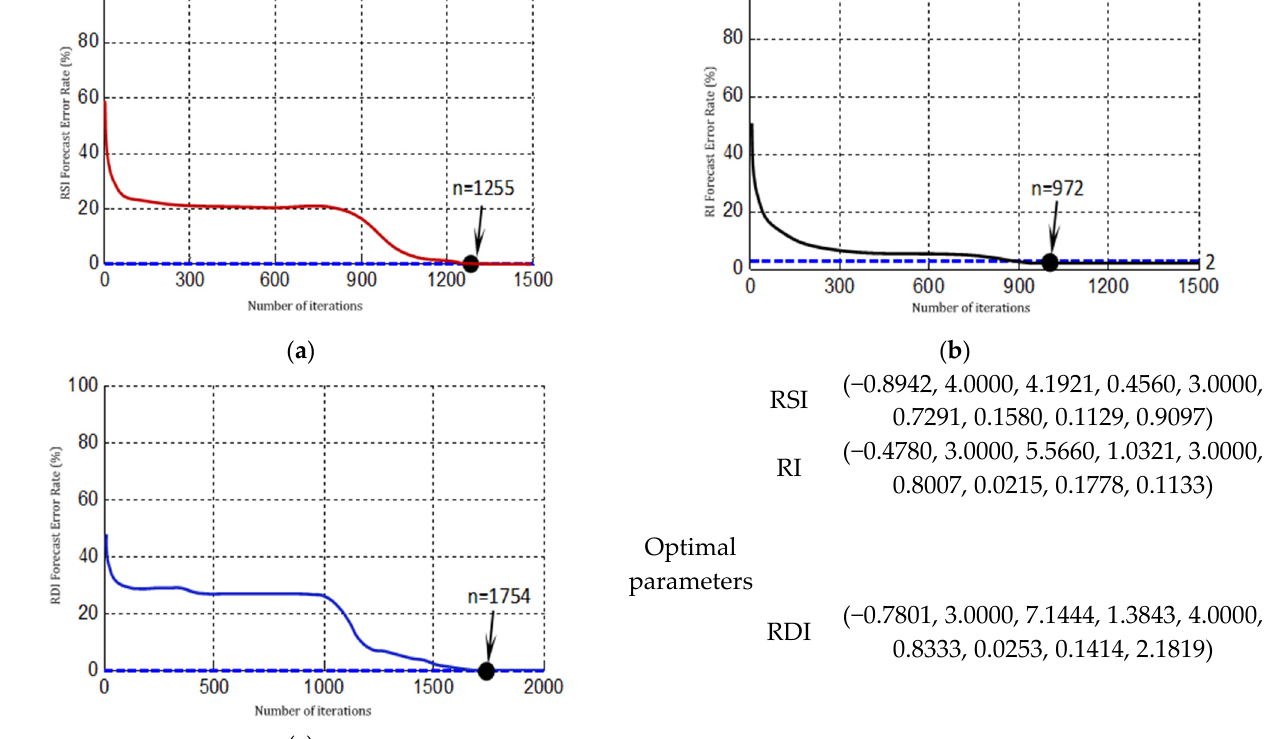
Figure 7. Prediction of pellet metallurgical performance based on objective algorithm. ( a ) The relationship between the number of iterations and the error rate of RSI forecast. ( b ) The relationship between the number of iterations and the error rate of RI forecast. ( c ) The relationship between the number of iterations and the error rate of RDI forecast.